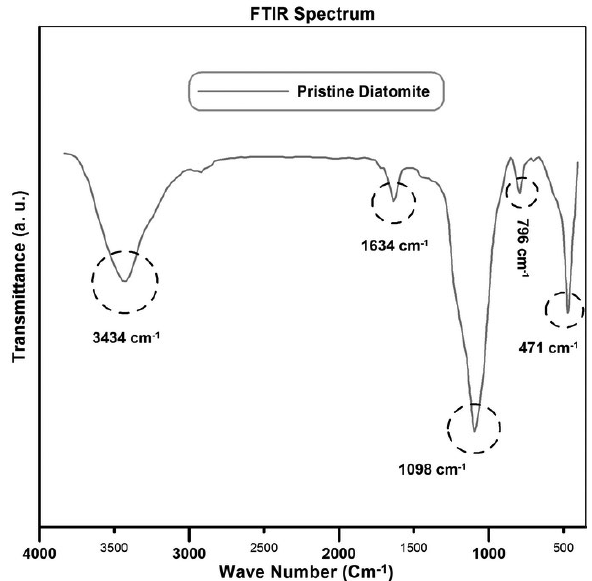
Figure 1 : FTIR spectrum of the pristine diatomite